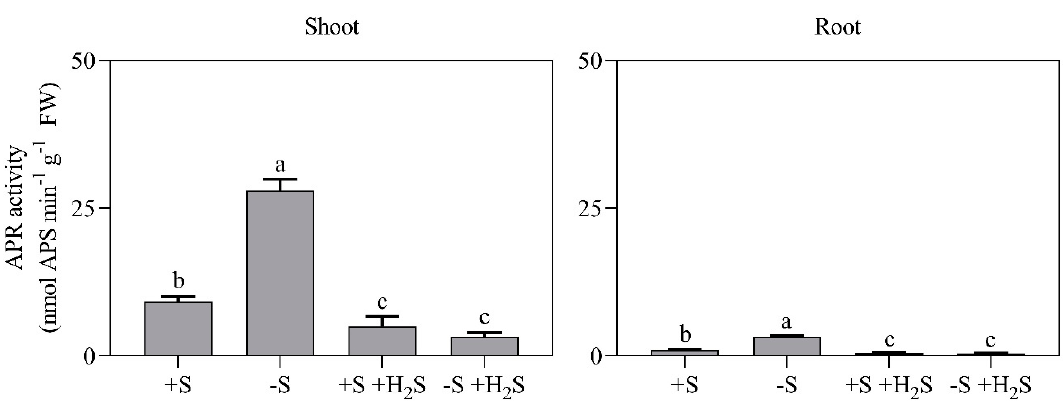
Figure 4. APR activity in barley shoots and roots in the presence and absence of a H 2 S and sulfate supply. For experimental details, see the legend of Figure 1. Data represent the average of 3 measurements with 3 plants per measurement ( ± SD). Significant di ff erences between treatments are indicated with di ff erent letters ( P ≤ 0.05; two-way ANOVA; Tukey’s HSD test as a post-hoc test).